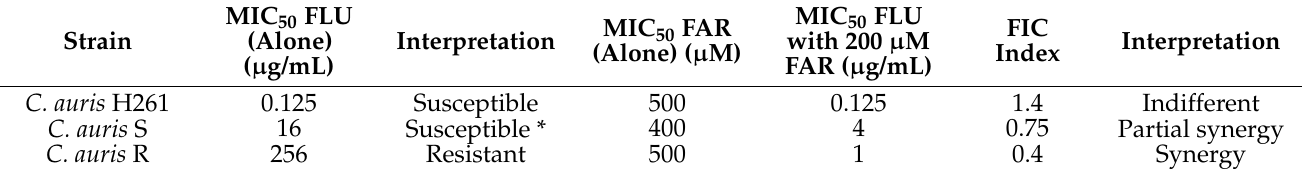
Figure 3. Synergistic effect of FAR (200 µ M) in combination with FLU determined by changes in MIC 50 of FLU. MIC 50 values of FLU alone are marked with a black arrow. MIC 50 of FLU combined with FAR are marked with a white arrow. MIC 50 of FLU remained without change for C. auris H261 ( A ), MIC 50 of FLU shifted from 16 µ g/mL to 4 µ g/mL for C. auris S ( B ), MIC 50 of FLU shifted from 256 µ g/mL to 1 µ g/mL for C. auris R ( C ). Data represent the average of 3 independent experiments performed in triplicate. Table 1. Synergy between FLU and FAR (200 μ M) of C. auris isolates determined according to MIC 50 values.